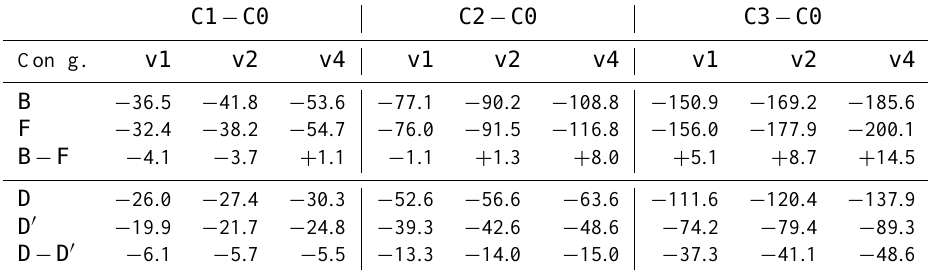
Table 3. Simulated changes in VAF (cm) relative to corresponding constant future-climate experiments at 500 years from the present for the configurations B and F and their differences and the two configuration D and D (cid:48) and their differences. C1 − C0 C2 − C0 C3 − C0 Config. v1 v2 v4 v1 v2 v4 v1 v2 v4 B − 36 . 5 − 41 . 8 − 53 . 6 − 77 . 1 − 90 . 2 − 108 . 8 − 150 . 9 − 169 . 2 − 185 . 6 F − 32 . 4 − 38 . 2 − 54 . 7 − 76 . 0 − 91 . 5 − 116 . 8 − 156 . 0 − 177 . 9 − 200 . 1 B − F − 4 . 1 − 3 . 7 + 1 . 1 − 1 . 1 + 1 . 3 + 8 . 0 + 14 . 5 D − 26 . 0 − 27 . 4 − 30 . 3 − 52 . 6 D